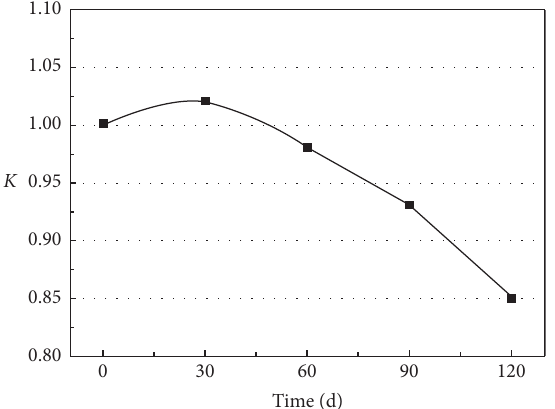
Figure 9: Variation of corrosion resistance coefficient of concrete specimens over